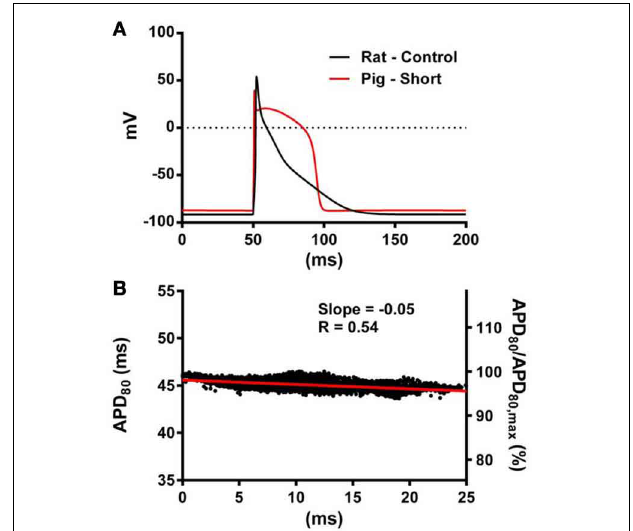
FIGURE 9 | The influence of AP morphology on coupling of AT and APD. In the rat geometry simulations of rat kinetics were compared to a modified pig kinetics model (P k , short R g ) whereby G Ks and G Ks were increased by a factor of 28.5 to match the APD 80 of the rat model. (A) Single cell AP traces comparing the rat and modified pig kinetics. Whole rat ventricle simulations were paced at the mid LV free wall. (B) AT-APD plot shown for P k , short R g simulation. The comparative AT-APD plot for an R k R g simulation is shown in Figure 3G . Slope of linear correlation analyses is indicated. Secondary y -axes show APD 80 expressed as a percentage of maximum APD 80